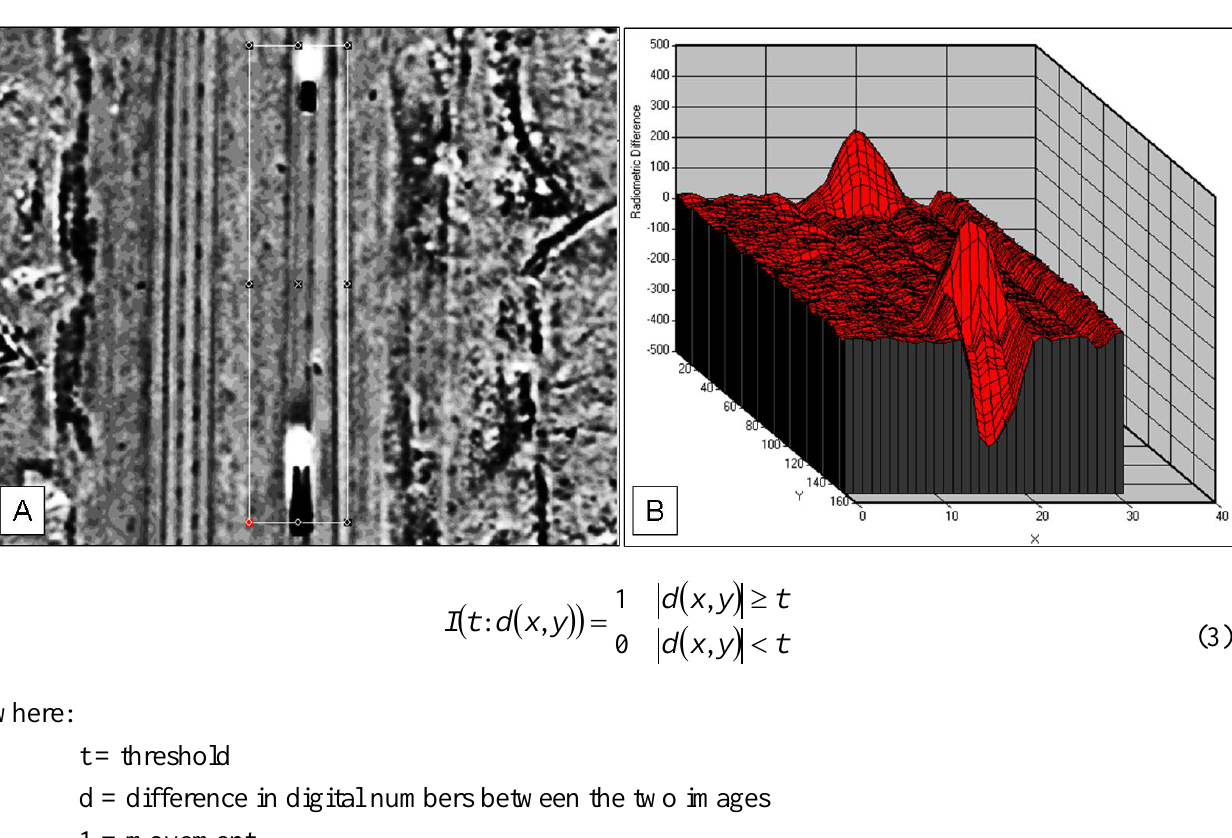
Figure 1. The difference in digital numbers for a highway segment containing two automobiles (a) with the movement of a passenger car and tractor trailer shown as spikes and valleys in contrast to the normal response (b)